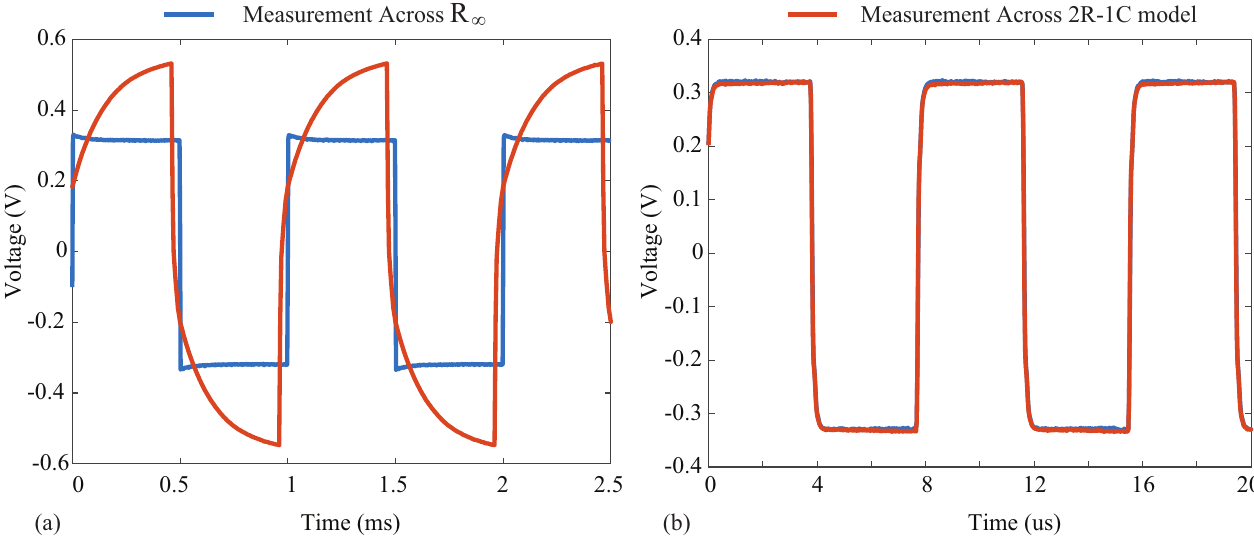
Figure 11. Voltage waveform collected using a Keysight DSO-X4054A oscilloscope in the setup of Figure 10 to measure voltage across R ∞ (blue line) and the complete 2 R − 1 C model (orange line) at ( a ) 1 kHz and ( b ) 128